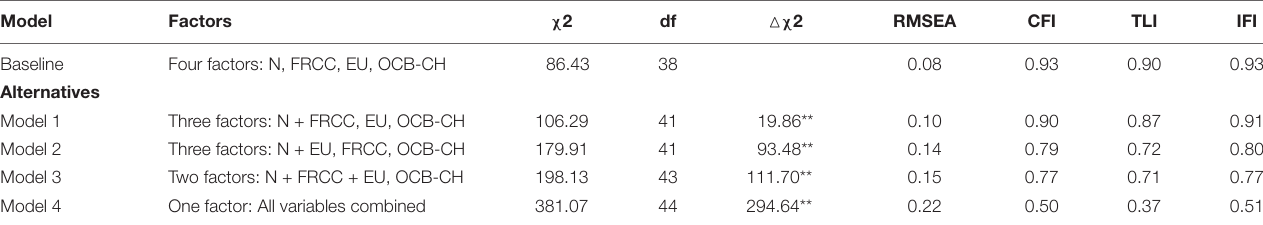
TABLE 4 | Study 2 results of confirmatory factor